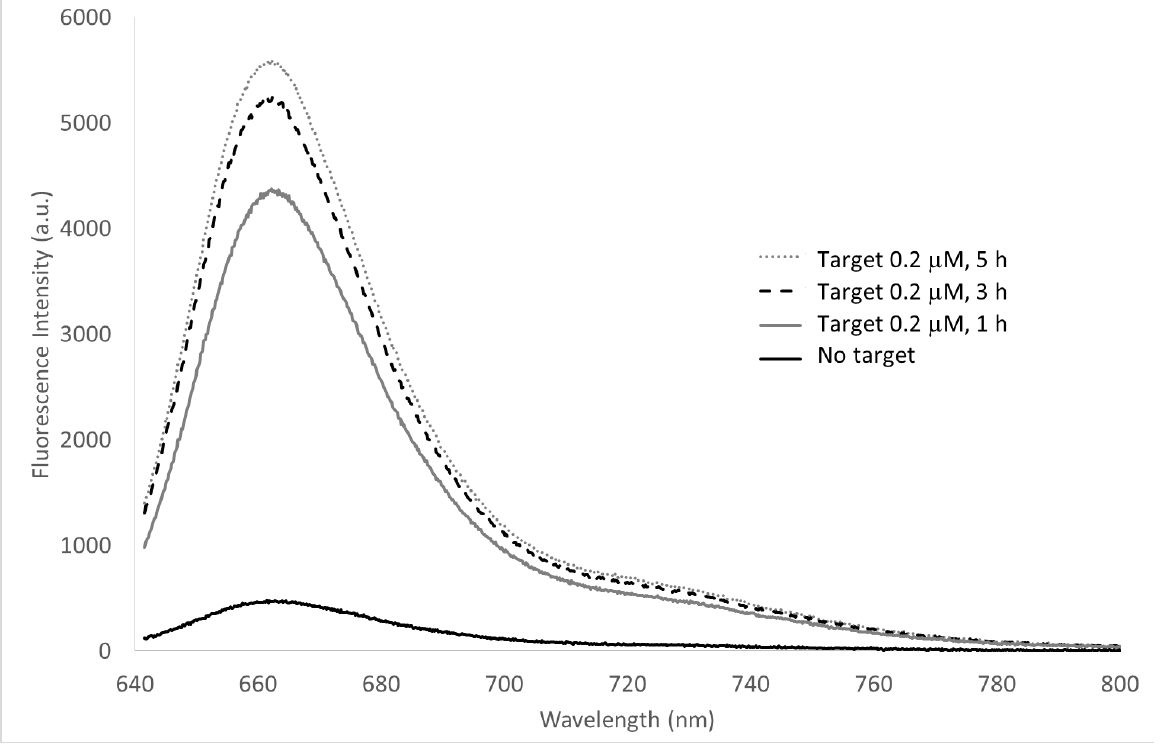
Figure 4. Fluorescence spectra of the molecular beacon (0.1 µM) after incubation for 1, 3